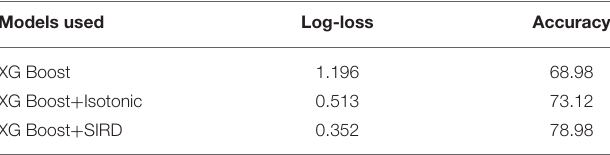
TABLE 4 | Results of using SIRD, isotonic regression to calibrate the XG Boost